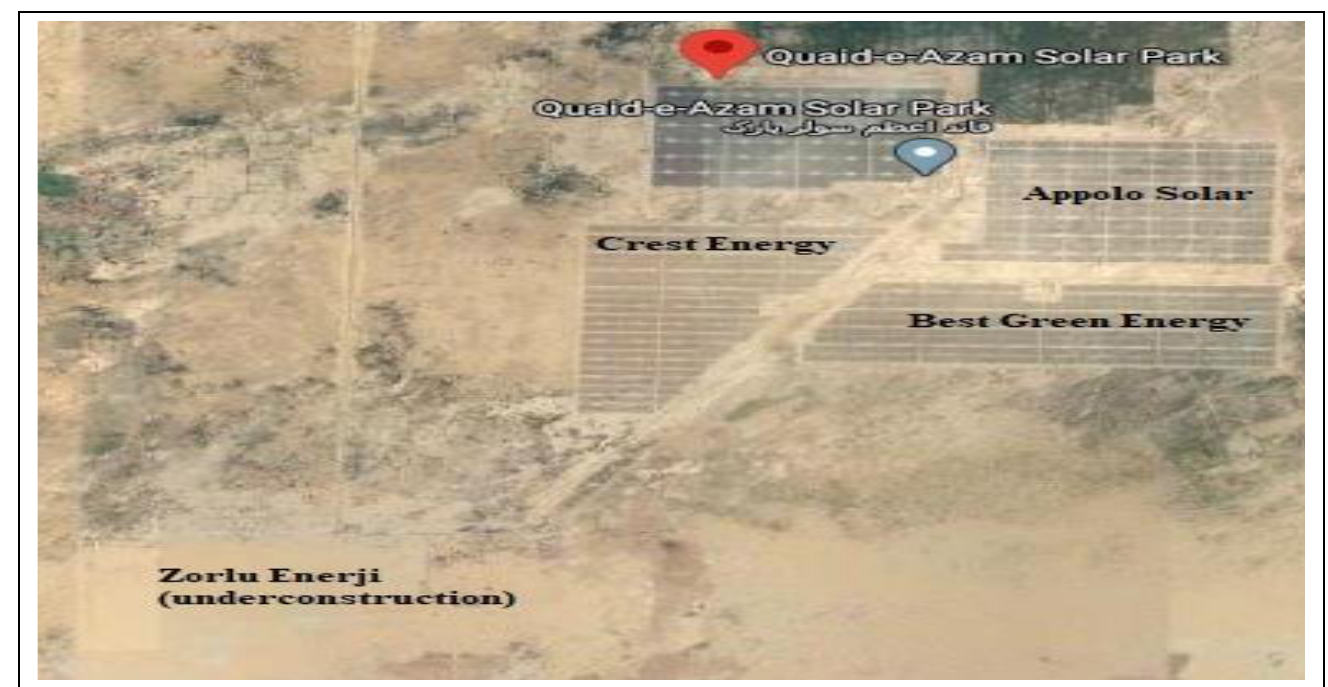
Fig. 1. Global horizontal irradiance map of Pakistan [18]